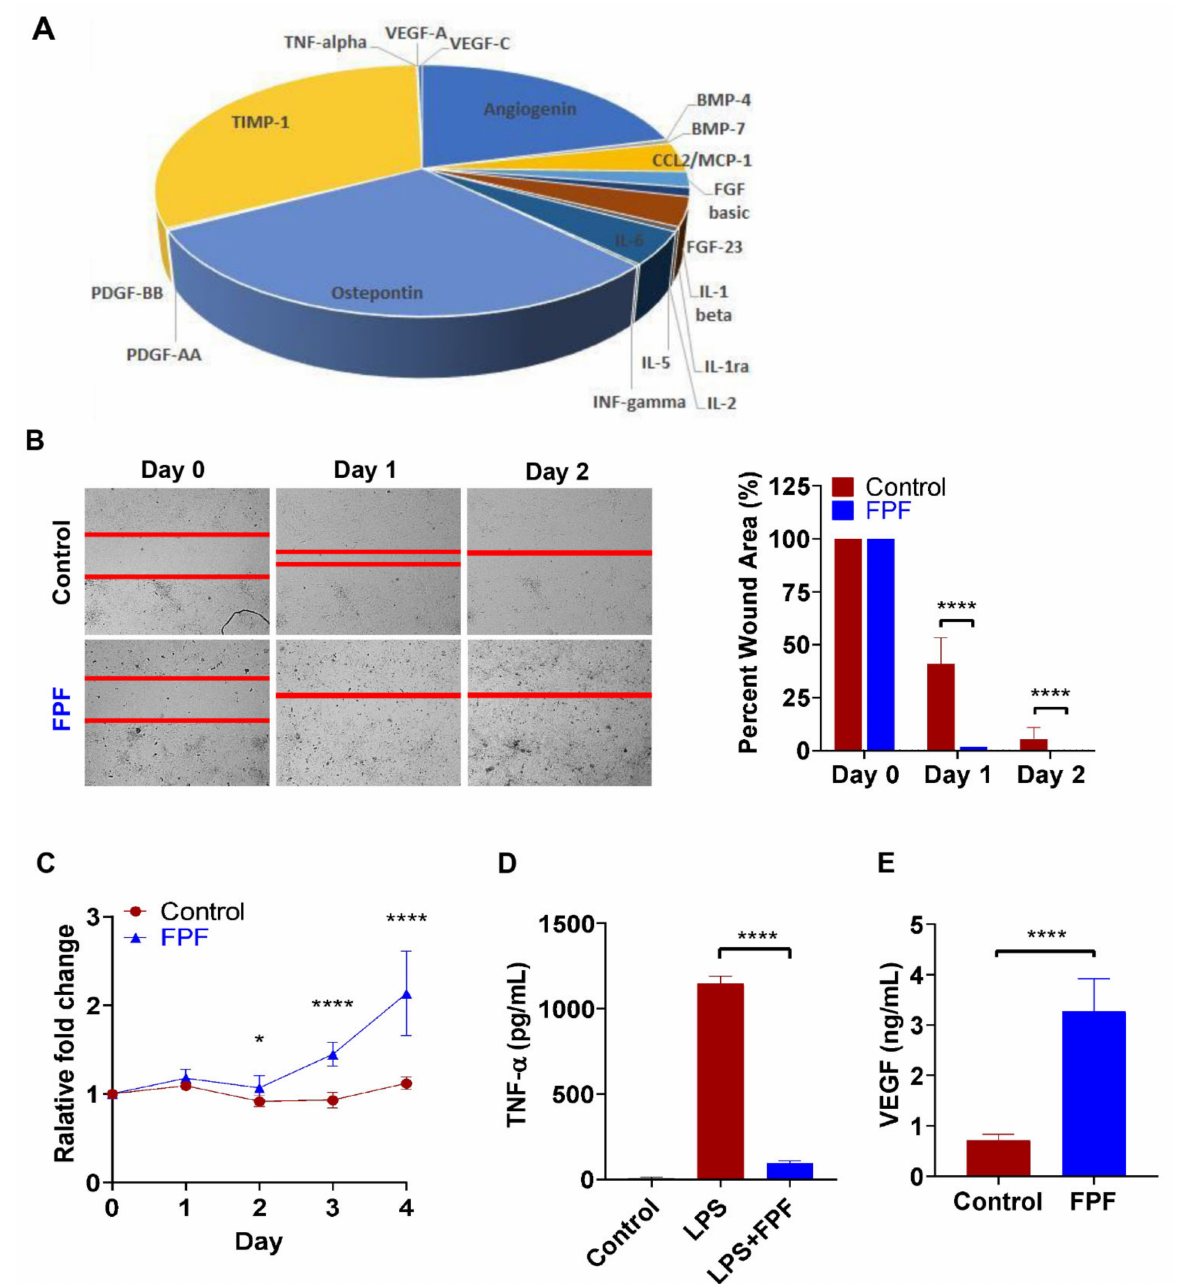
Figure 2. Tissue injury associated beneficial factors and their regenerative effects. ( A ) Representative presence of growth factors in FPF as determined by Luminex. N = 3 donors. ( B ) Representative photograph of HDF wound closure after incubation with FPF conditioned media. Graph shows significant reduction in wound area upon treatment with FPF conditioned media. Red line shows scratch gap closure ( C ) The viability of HDF cells was measured using MTT assay, and data are expressed as relative fold change compared to day 0. ( D ) Anti-inflammatory activity of FPF was evaluated by inhibition of TNF α release from stimulated human PBMCs. Unstimulated and stimulated PBMCs alone served as positive and negative controls, respectively. ( E ) Angiogenic activity of FPF was determined by a cell-based reporter assay that measured VEGF stimulation and inhibition of KDR (VEGFR-2) using luciferase as a readout. Results are shown as mean ± SD ( N = 3). * p < 0.05, **** p <